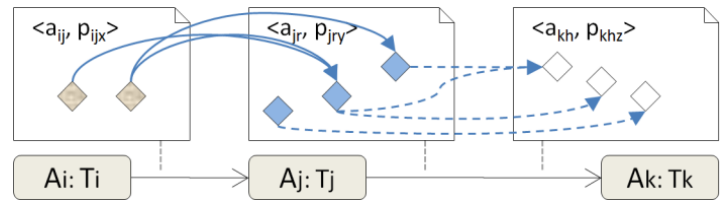
Figure 3. Target processing related to information objects. The arrows represent the transformations of information objects between different